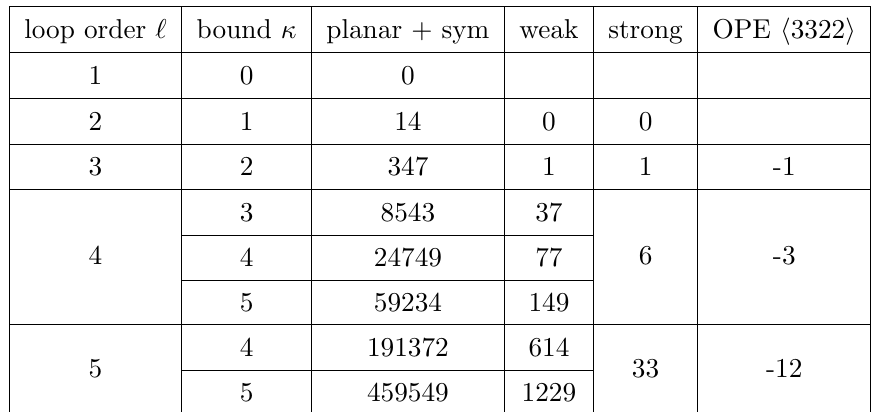
Table 3 . Number of free coe(cid:14)cients in the ansatz for the set of all ‘ -loop correlator integrands (2.6) after imposing planarity and discrete symmetry constraints, weak (3.1) and strong (3.3) light-cone OPE constraints for di(cid:11)erent values of the saturation bound (cid:20) in (2.15). We assume the correlator hO 2 O 2 O 2 O 2 i is already known. In the last column we show the number of additional constraints coming from exponentiation property of the Euclidean OPE for the correlator hO 2 O 2 O 3 O 3 i in the channel (14) ! (23); they are independent from the light-cone OPE